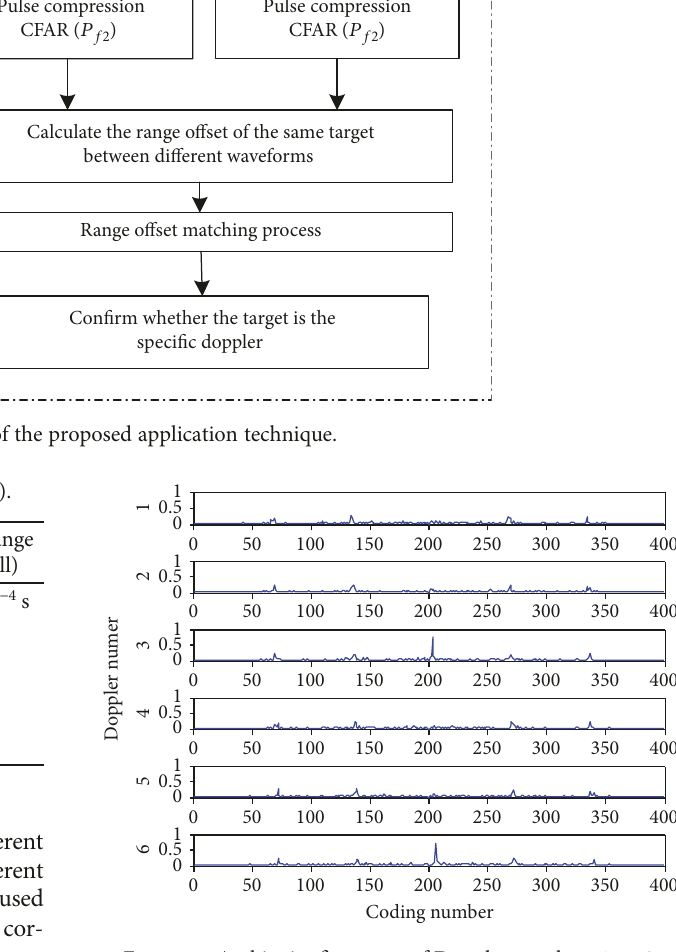
Figure 5: Ambiguity fi gure cut of Doppler numbers 1 to